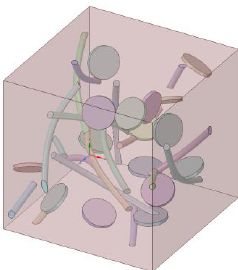
Figure 12. A model of randomly distributed 1% vol. GNPs and 1% vol. CNTs.